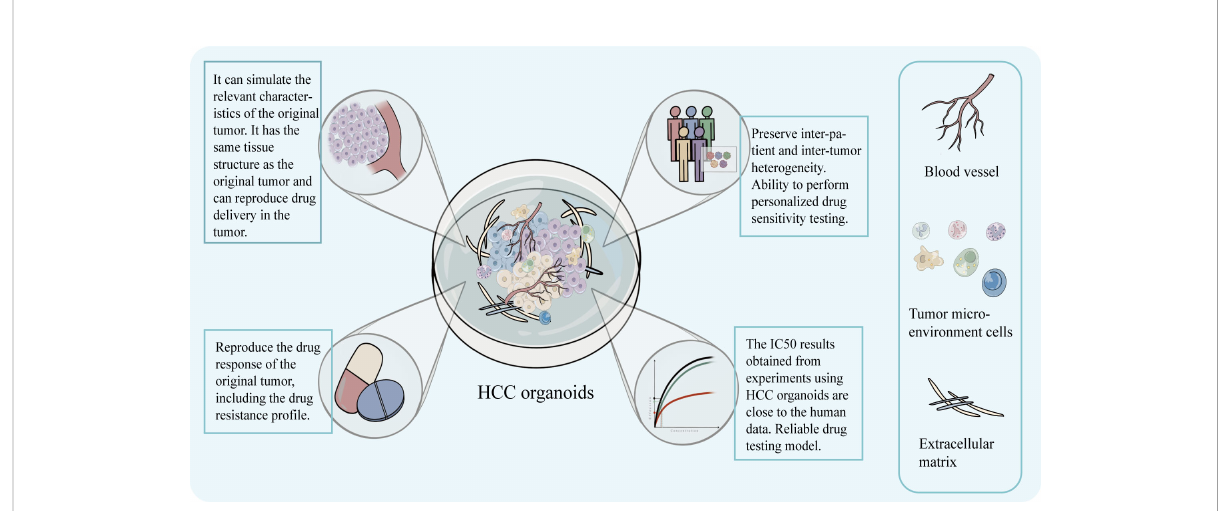
FIGURE 4 The model can preserve the structural characteristics of the original tumor, has advantages in simulating the drug concentration layer related to the treatment and can obtain IC50 that is closer to the real data of the human body. It can preserve the intra-tumor and inter-patient heterogeneity, drug response, and drug resistance characteristics, and help realize personalized targeted drug susceptibility